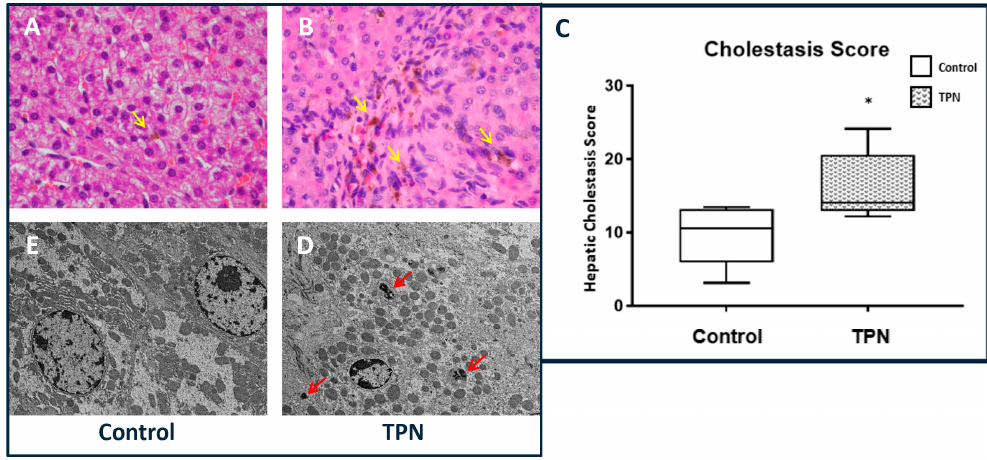
Figure 2: Hepatic cholestasis. (A,B) Hematoxylin and eosin (H&E) stain, 40× magnification showing increased cholestasis in TPN animals (yellow arrows). (C) Cholestasis score was significantly